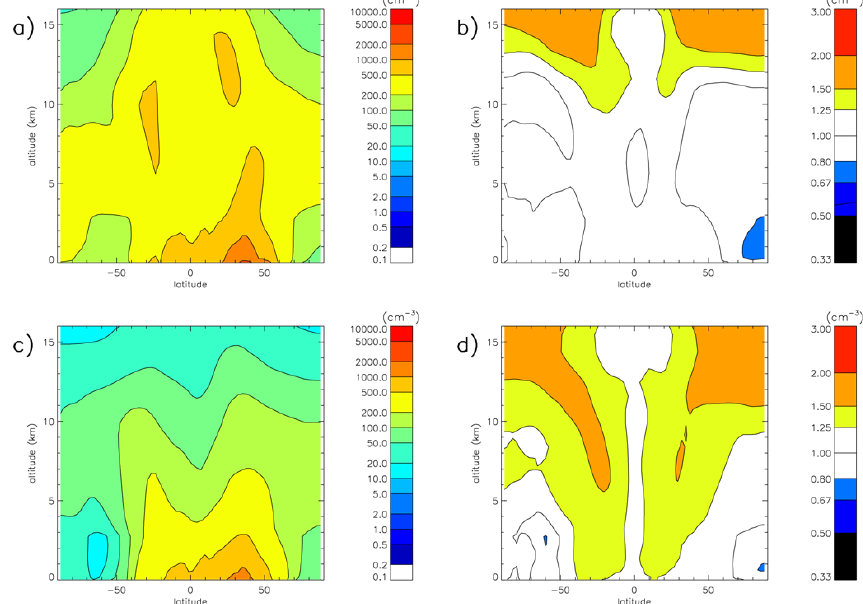
Fig. 10. Latitude-altitude plots of zonal-mean concentrations of (a) CN (all particles with dry diameter > 10nm) and (c) CCN 50 (all soluble particles with dry diameter > 50nm), as simulated by GLOMAP-mode (v6R) on the annual-mean. The ratio of GLOMAP-mode (v6R) to GLOMAP-bin simulated CN and CCN 50 are shown in panels (b, d) , respectively. Regions coloured yellow, orange and red in the relative bias maps indicate where GLOMAP-mode is higher than bin by 25–50, 50–100 and 100–200%, respectively, whilst light-blue, dark-blue and black indicate where bin is higher by the same proportions. Regions where the two schemes are within 25% are colored